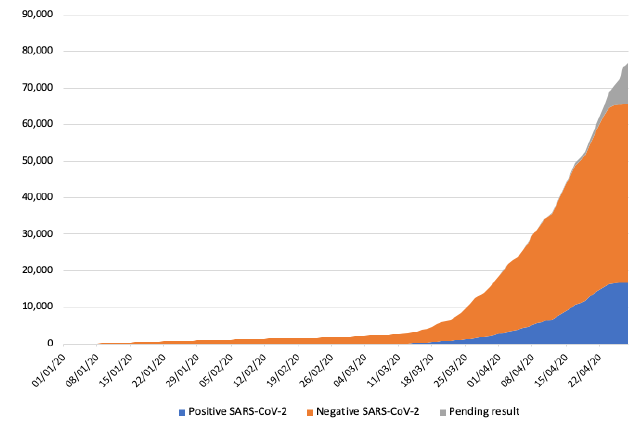
Figure 10. Evolution of the cases registered in Mexico as